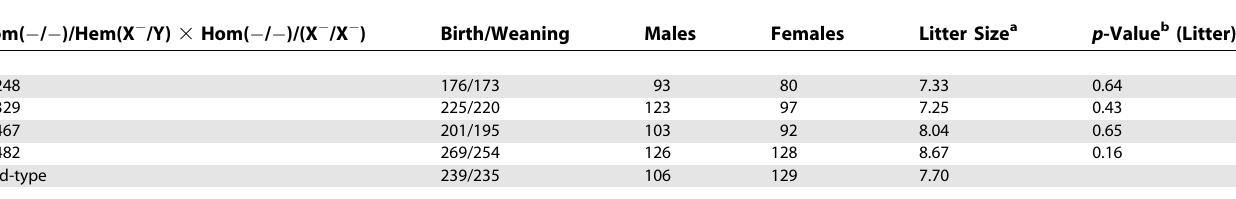
a Average litter size at birth. b Unpaired t -test of litter size compared to wild-type. Hem, hemizygous; hom, homozygous. doi:10.1371/journal.pbio.0050234.t004 PLoS Biology |